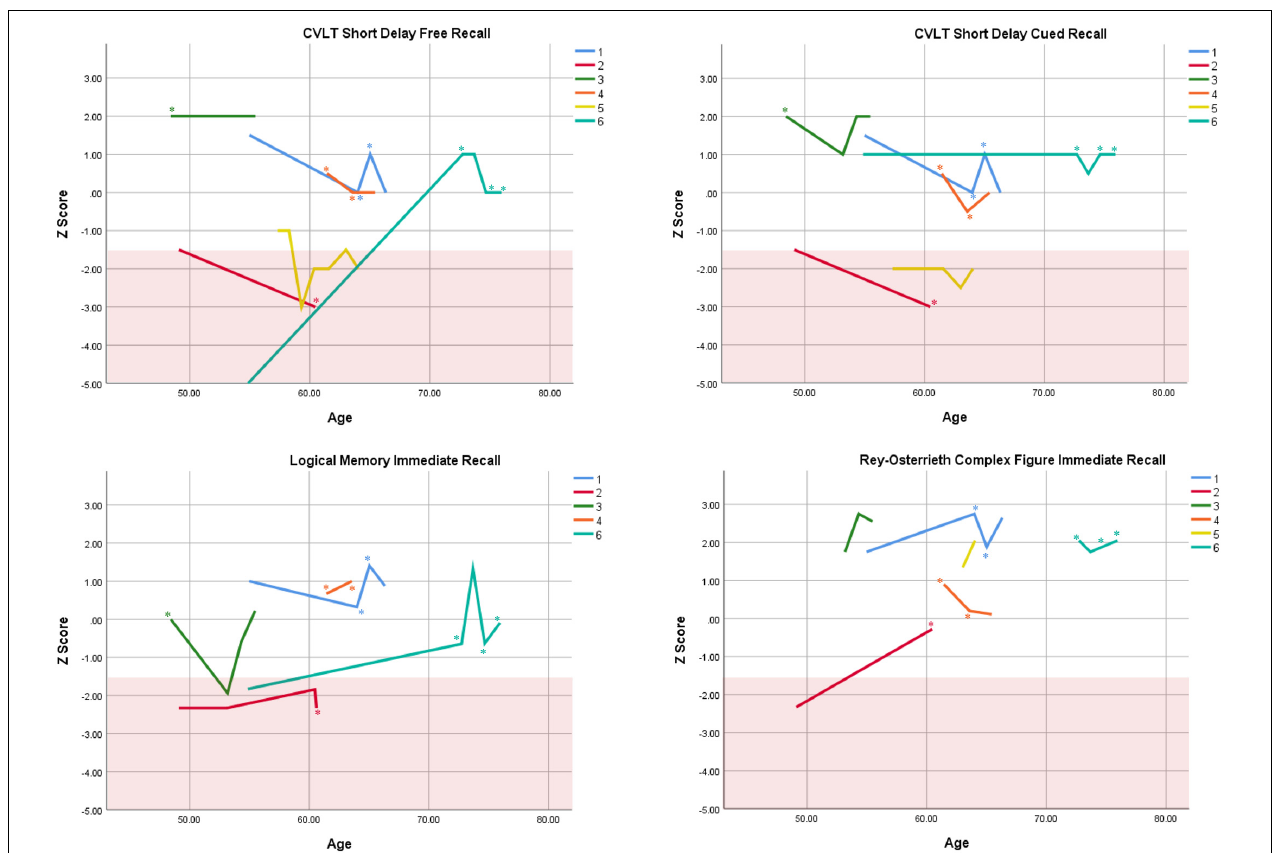
FIGURE 2 | Individual longitudinal performance on measures of immediate recall. Shaded red area represents impaired performance ( Z < –1.5). CVLT = California Verbal Learning Test. *Denotes clinically significant depressive symptoms at that visit (30-item GDS ≥ 10 or BDI-II ≥